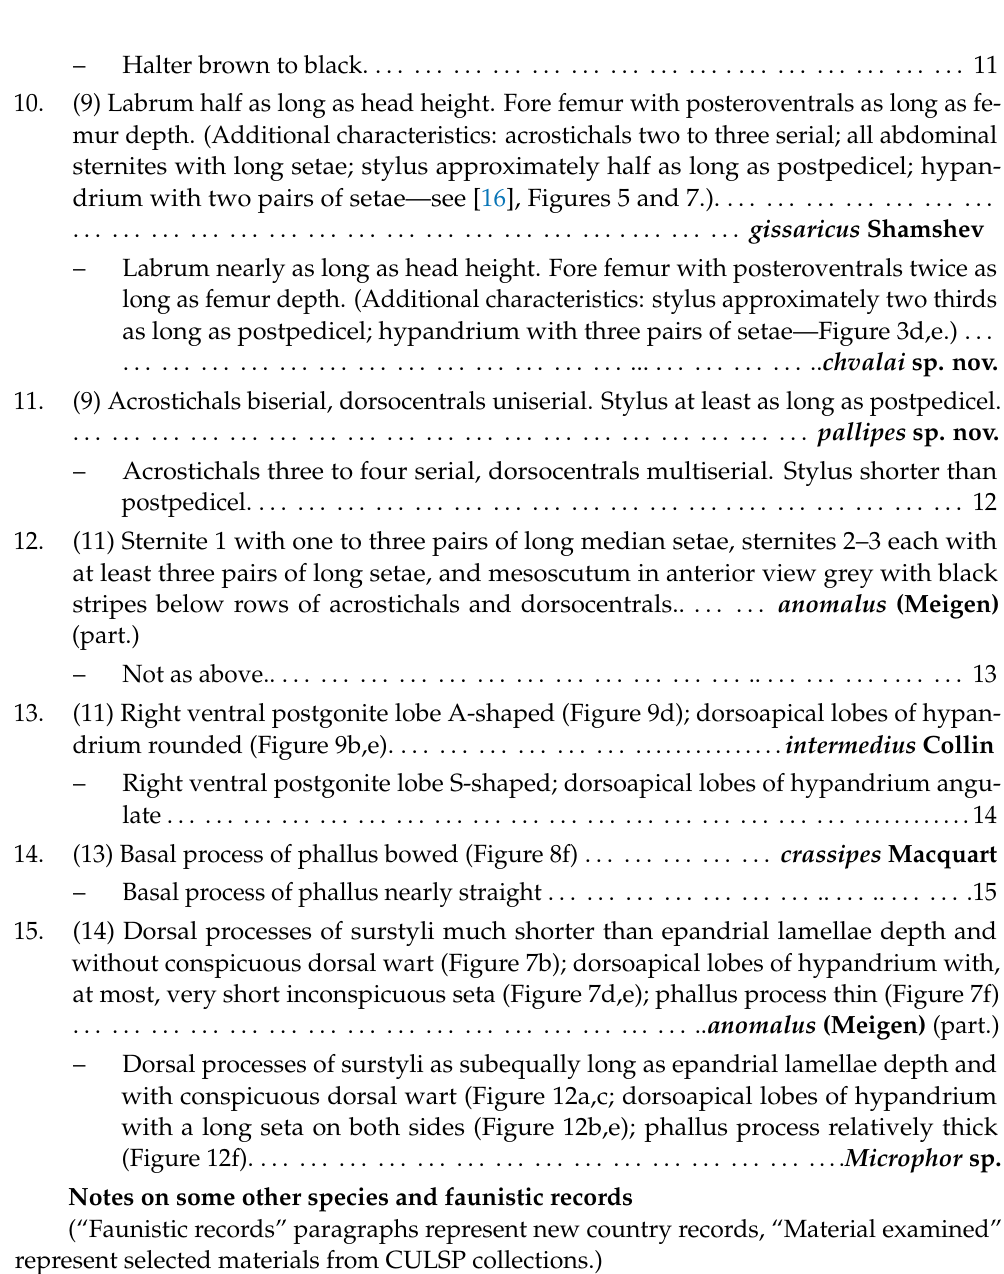
Notes on some other species and faunistic